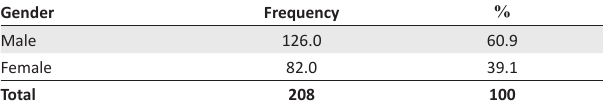
TABLE 5: Characteristic one: Gender of respondents.